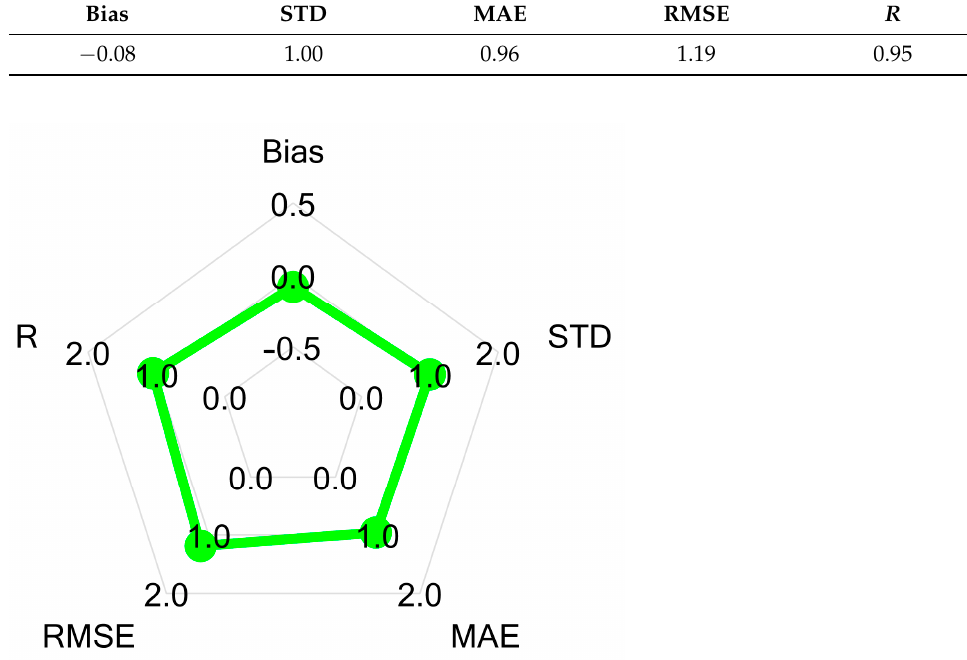
Figure 4. Comparison of ZTD outer accuracy (cm) between IGS and VMF collocated stations in radar map.